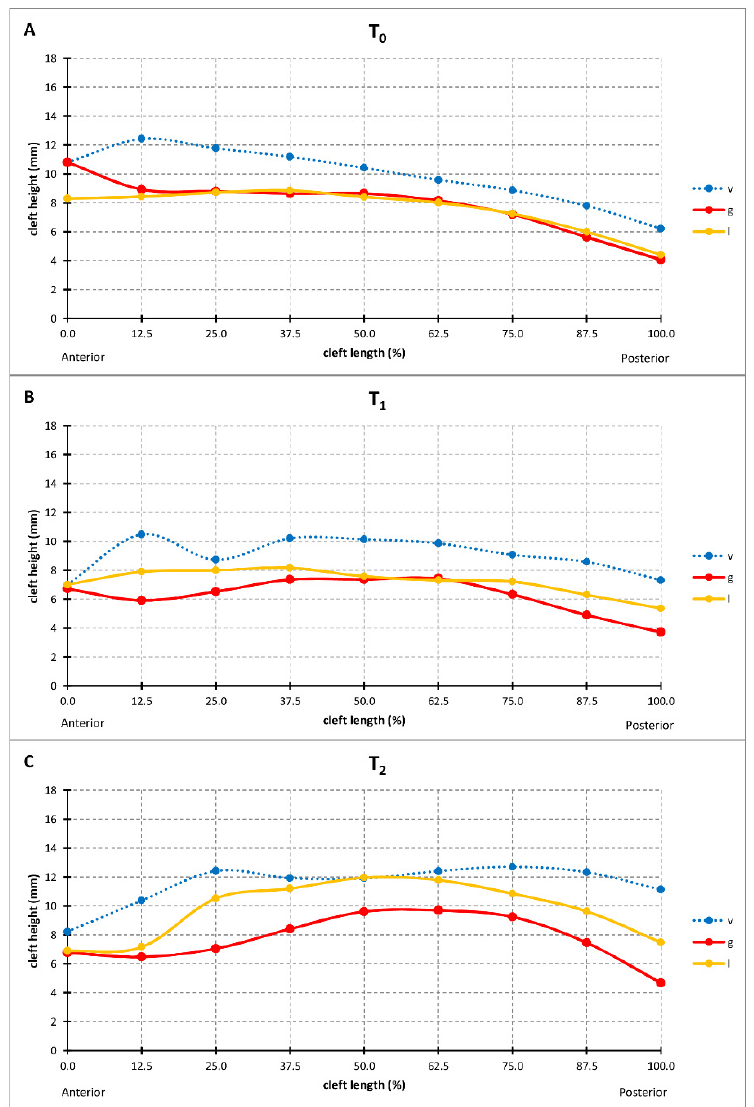
Figure 6. The median vertical height of vomer edge (v height), the junction between the palatal shelf of the greater segment and vomer (g height), and the palatal shelf ridge of the lesser segment (l height) at T0 ( A ), T1 ( B ), and T2 ( C ).